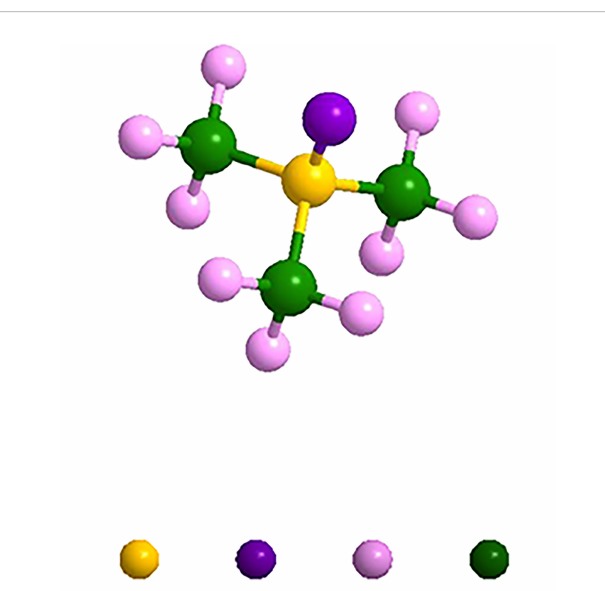
FIGURE 1 Molecular structure of TMAO. The formula is C 3 H 9 NO, which consists of three carbon atoms, nine hydrogen atoms, one nitrogen atom and one oxygen atom.